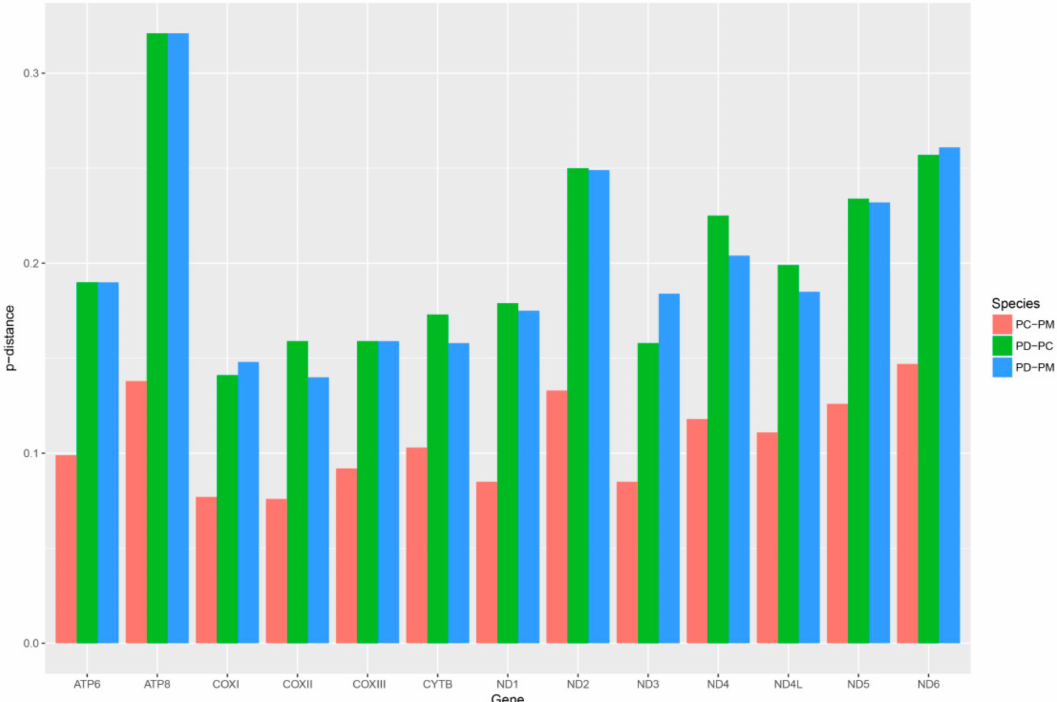
Figure 4. Overall mean p-genetic distances between P. canaliculata , P. diffusa and P. maculate for each of 13 PCG. Values were calculated using the first and second nucleotide positions, the total codon and over the full